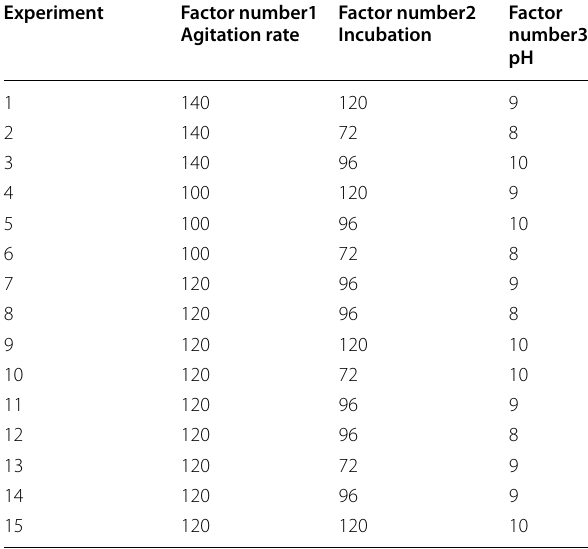
Table 1 Experiments of second step designed by response surface analysis